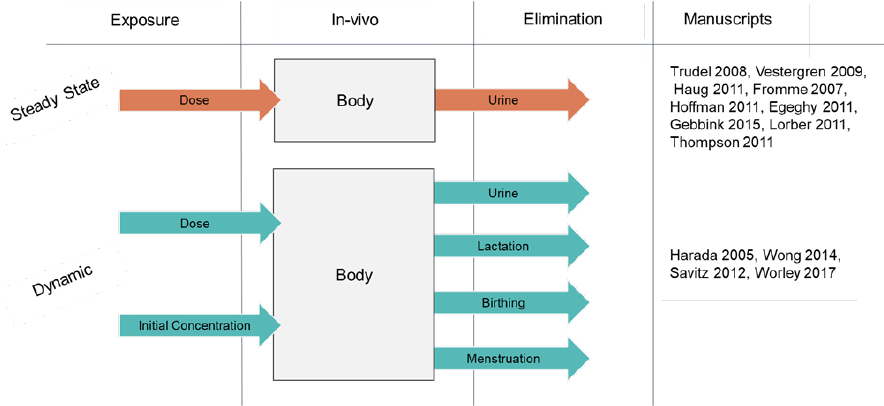
Figure 6. Commonly presented characteristics of OCH TK PFAS models [19,25,61,65 – Figure 6. 67,69,70,72,73,75,77,78] .